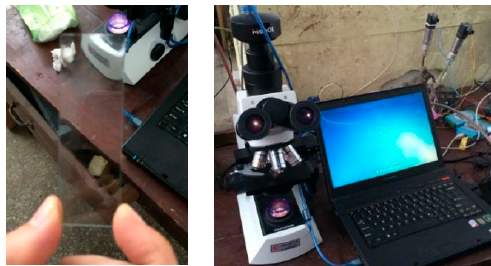
Figure 2. Glass slide coated with silicone oil and high-power microscope.